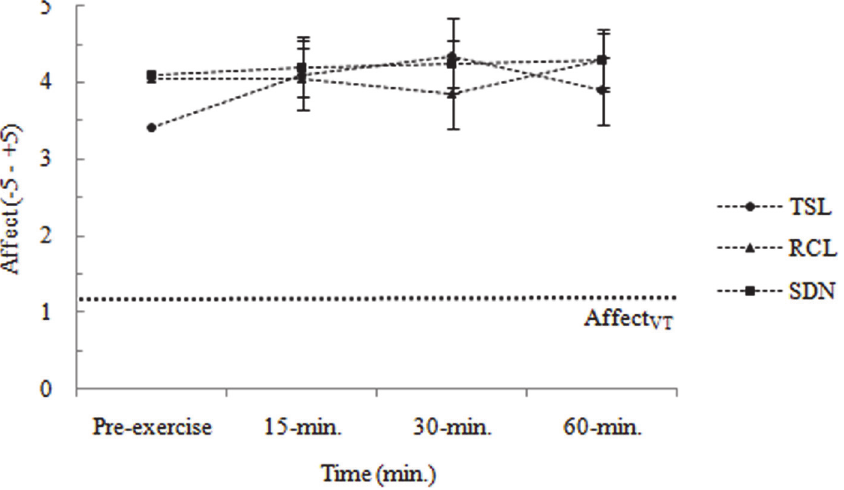
Affect VT : affect at-VT; VT: ventilatory